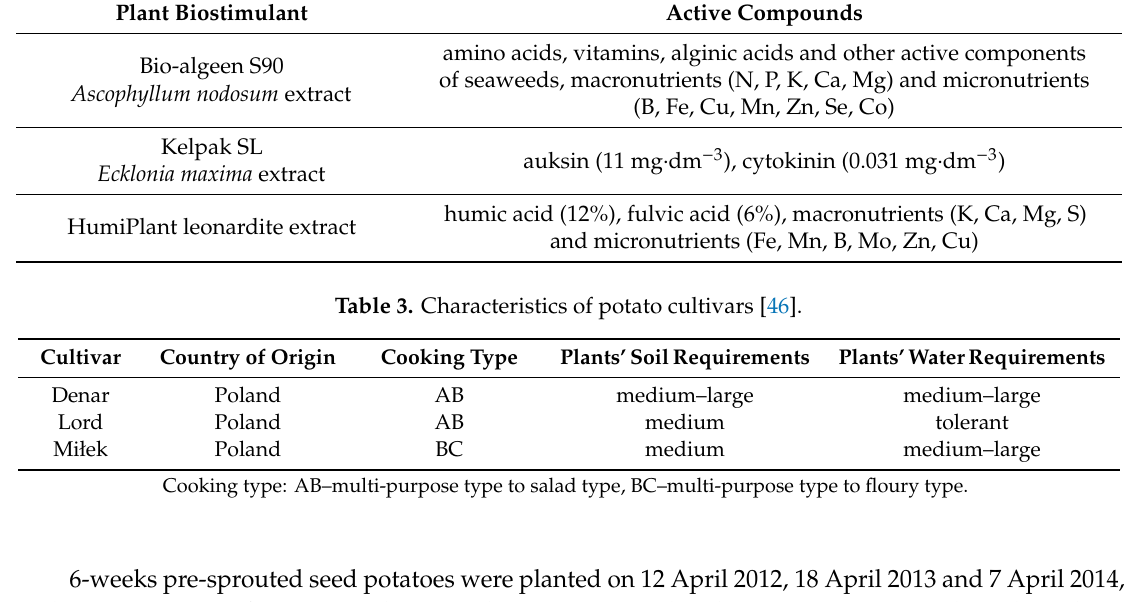
Table 2. Characteristics of plant biostimulants; according to manufacturers. Plant Biostimulant